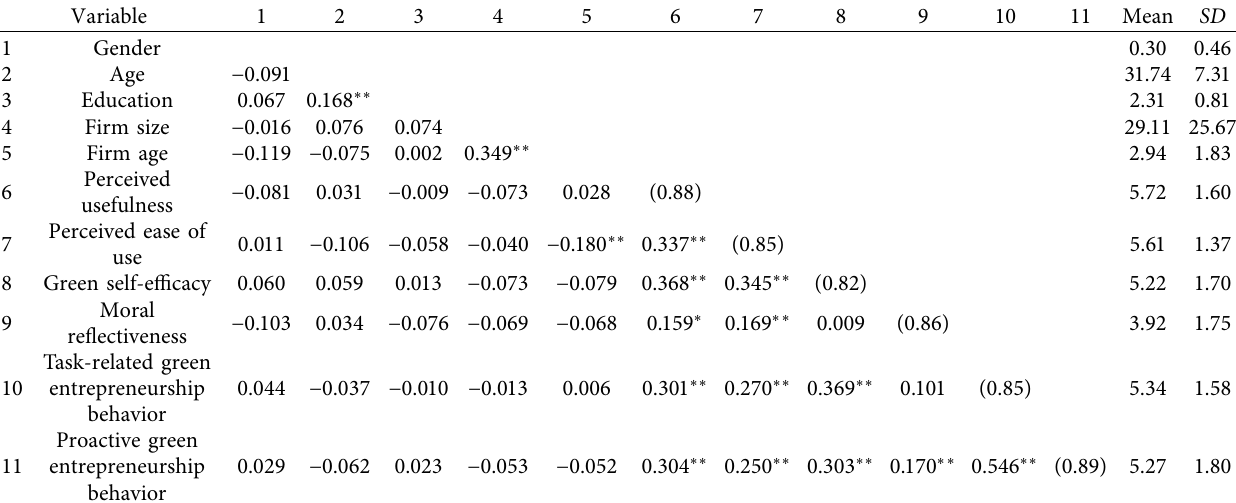
Table 1: Descriptive statistics and correlations.